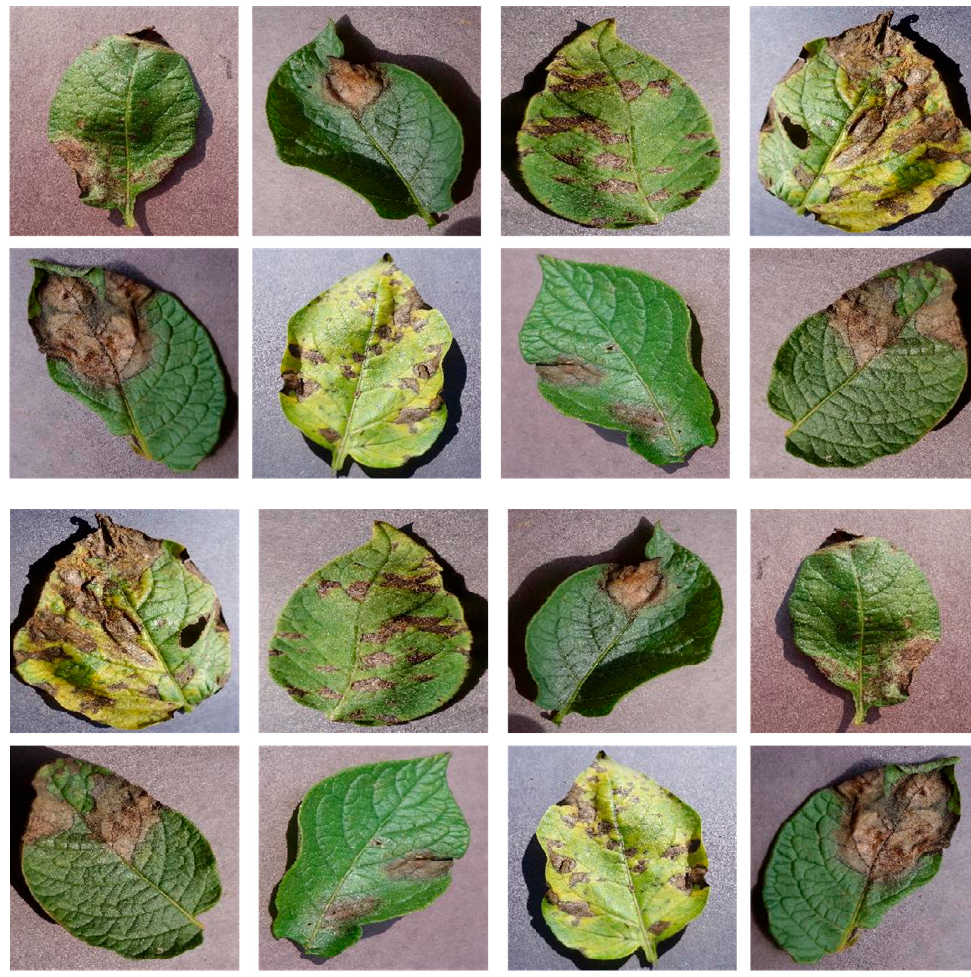
Figure 3. A visual figure of sample dataset. Table 2. List of categories included in the PlantVillage dataset without data augmentation.